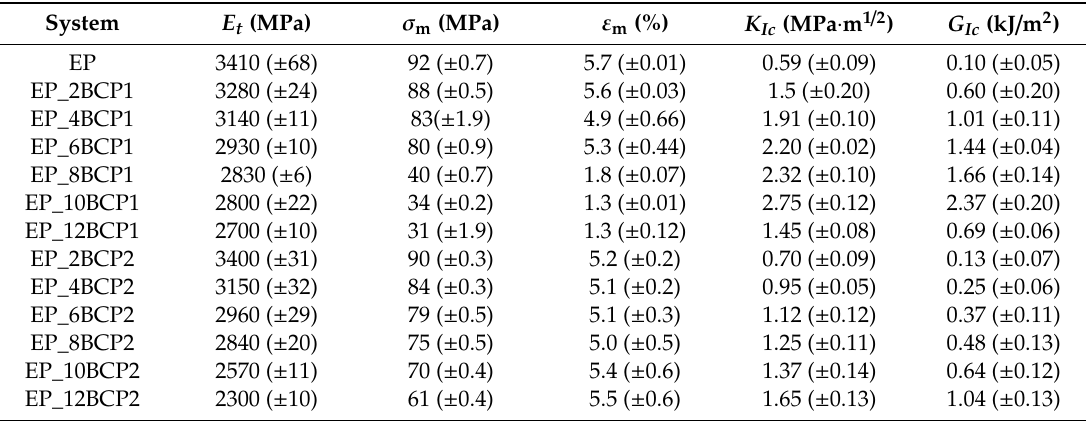
Figure 2. Representative stress-strain curves for epoxy modified systems with ( a ) BCP1 and ( b ) BCP2. Table 3. Tensile and fracture mechanics properties of reference epoxy system modified with di ff erent type of block copolymers measured at 23 ◦